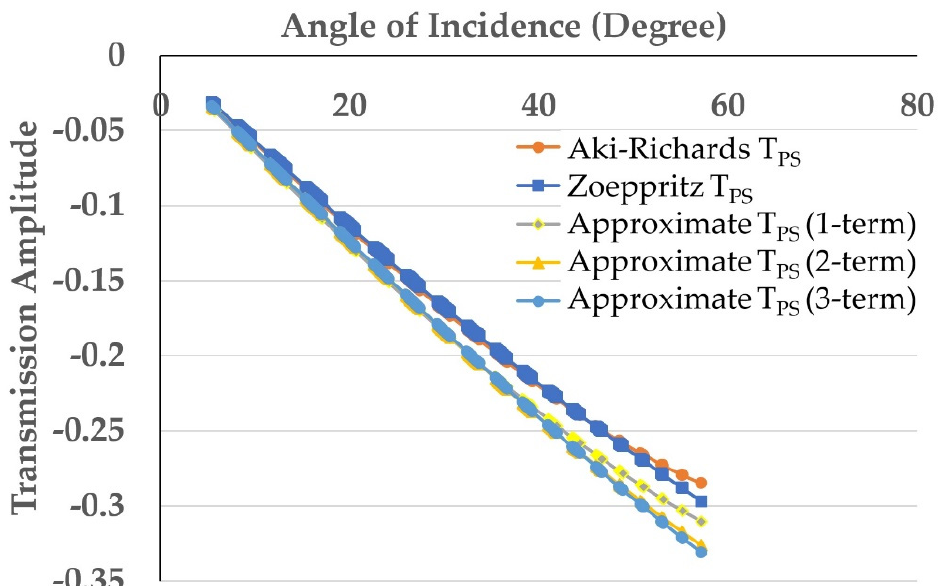
Figure 4. Fitting angle–amplitude (T PS ) data of CTP 38 in the oil reservoir.